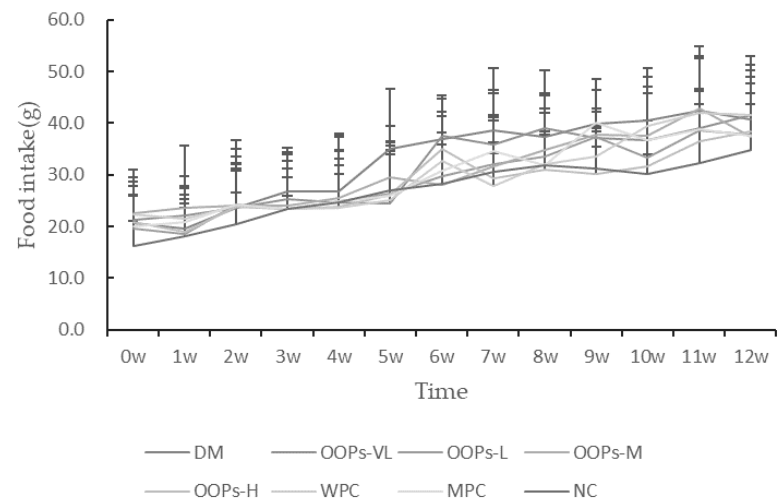
Figure 2. Effect of OOPs on food intake.